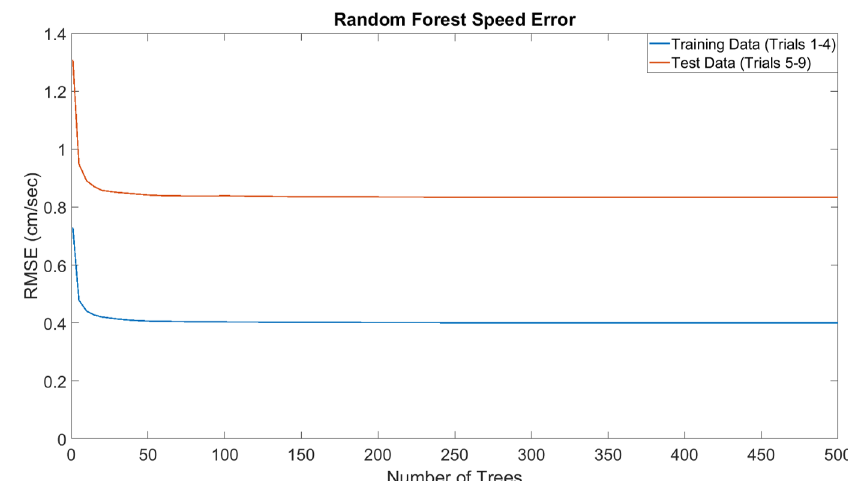
Figure 4. Analysis on Number of Trees: The Root Mean Square Error (RMSE) of the speed of the biobot is shown as a function of the number of trees in the random forest speed regression model, M s . We use 100 trees for our speed regression model because the RMSE does not decrease if additional trees are added. Four trials were used to train the random forest regression model and the errors are reported for both the training data and the test data. Each trial is approximately 30 min